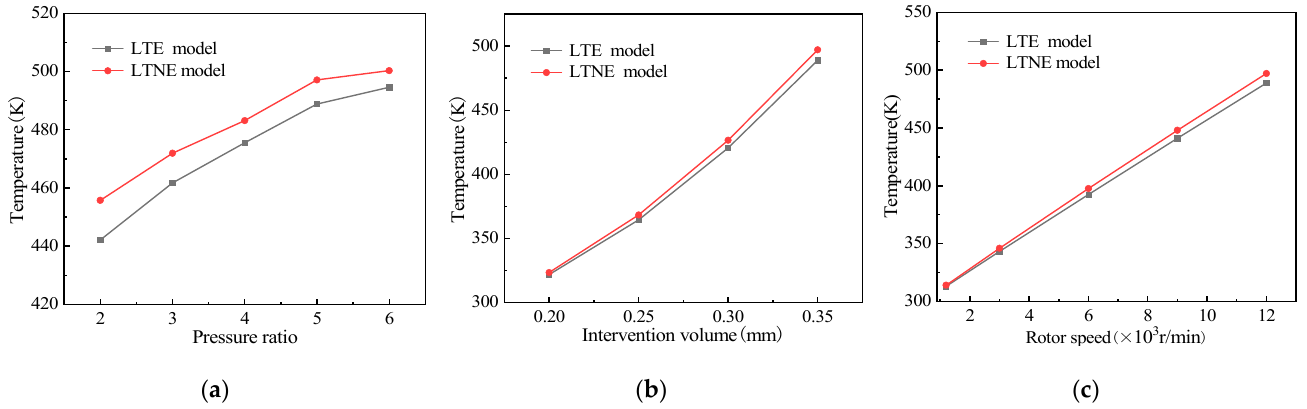
Figure 10. Variation of the maximum brush filament temperature with pressure ratio ( a ), interference amount ( b ), and rotational speed ( c ).